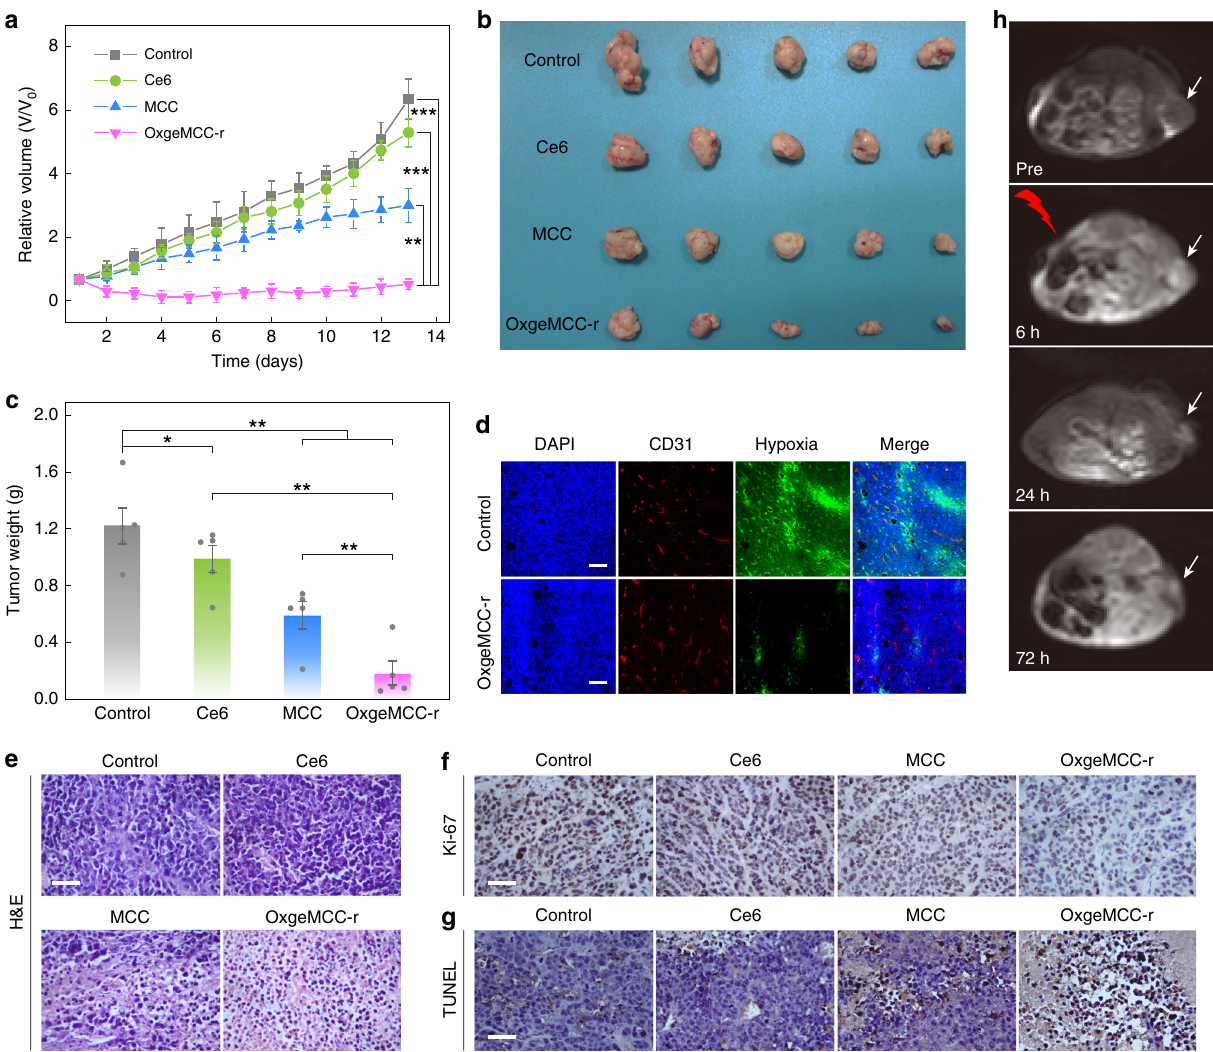
Fig. 8 In vivo PDT ef fi ciency assessments. a Relative tumor volumes of mice after various treatments (control, Ce6, MCC, and OxgeMCC-r, n = 5). The last three groups were treated with laser irradiation: 5 min with a power density of 100 mW cm − 2 . Injection dose is 100 µ L, with a Ce6 concentration of 4 mg kg − 1 . b Photographic images of tumors excised from different groups after various treatments indicated. c Average weights of tumors from different groups of mice after various treatments indicated. d Representative hypoxia immuno fl uorescence images of tumor slices. Nuclei, blood vessels, and hypoxic regions were stained by 4 ’ ,6-diamidino-2-phenylindole (DAPI, blue), anti-CD31 antibody (red), and anti-pimonidazole antibody (green), respectively. Scale bar is 100 µ m. e H&E staining and f Ki-67 staining of tumor slices from different groups after various treatments. Scale bar is 50 µ m. g TUNEL staining of tumor slices from different groups indicated. Scale bar is 50 µ m. h MR imaging of tumor-bearing mouse at different treatment points. Data are presented as mean ± s.e.m. ( n = 5). Statistical analysis was performed via one-way ANOVA. *p < 0.05, **p < 0.01, ***p <